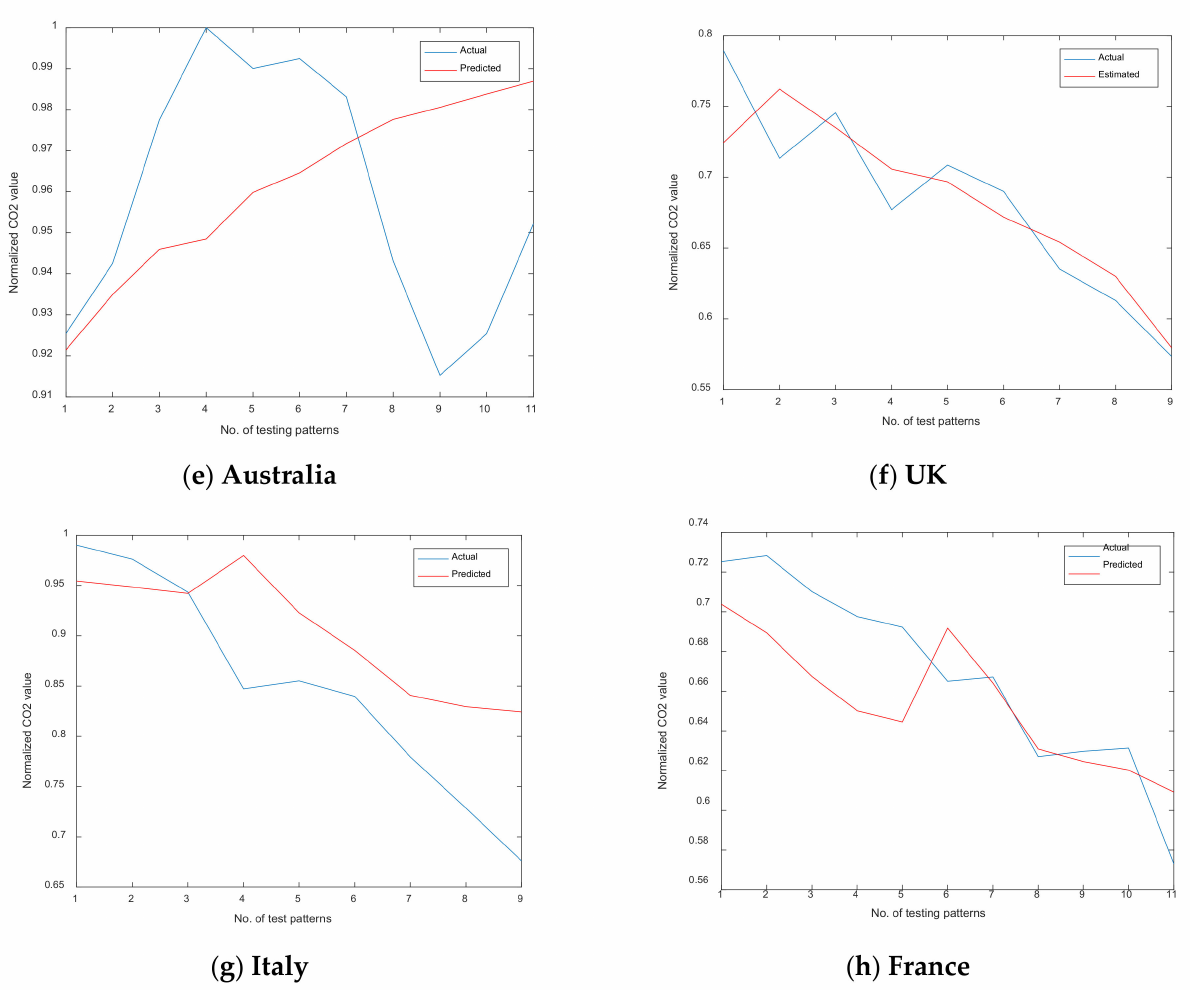
Figure 7. Comparison of the actual and estimated value of CO 2 emission using MLANN for Group-2 countries during